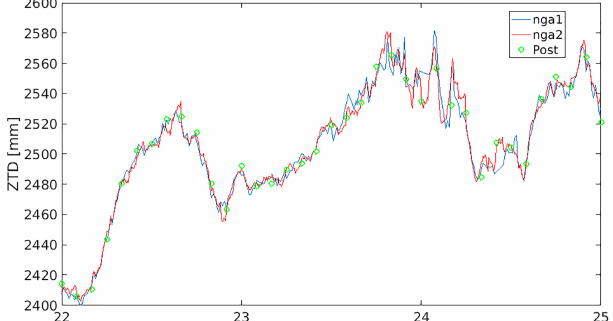
Figure 3. Time series of ZTD for 22 to 24 June 2016 for the NGA1 (blue) and NGA2 (red) solutions together with the ones ob- tained from a post-processing (green circles). The data are from the Ballerup (Copenhagen) station in Denmark. The x axis shows the days in June, while the y axis shows the ZTD